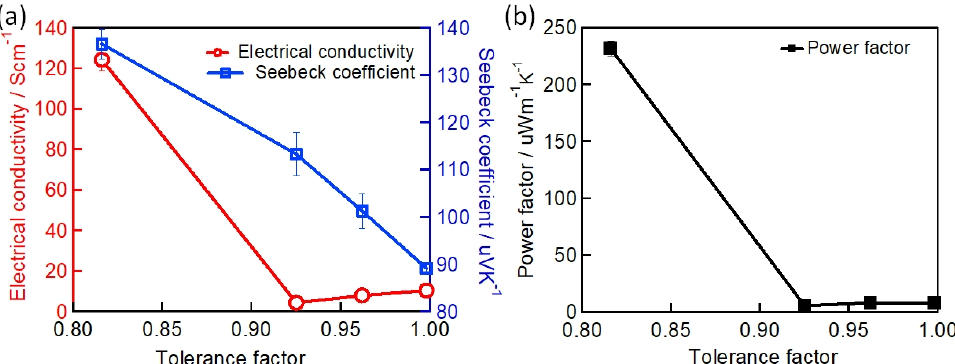
Figure 32. ( a ) Electrical conductivity and Seebeck coefficient variation with tolerance factor. ( b ) Calculated Power factor. Reproduced with permission from [147]. Copyright 2020, the Japan Society of